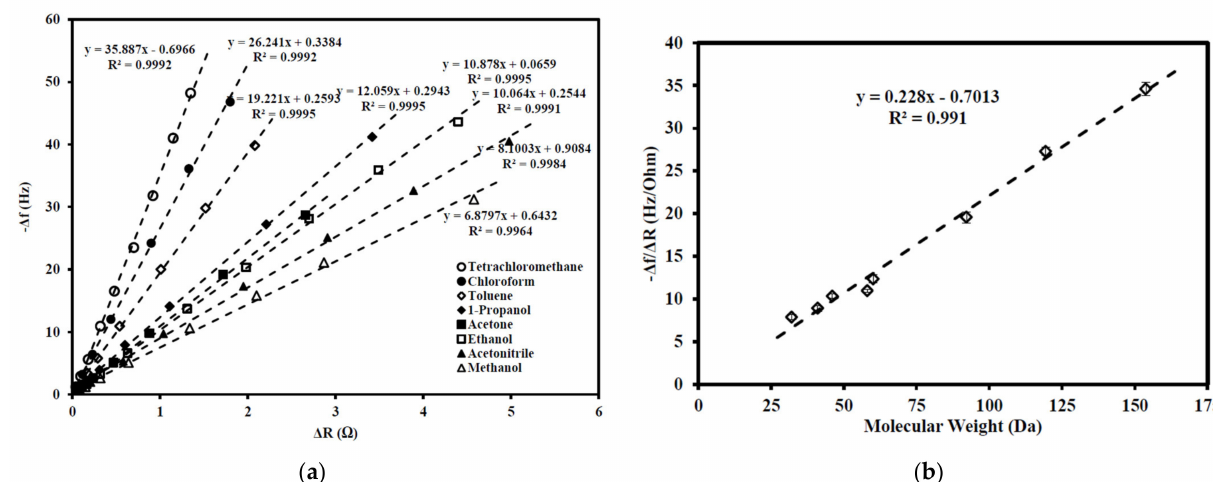
Figure 9. ( a ) Plots of ∆ f against ∆ R for a QCM sensor coated with a composite material on exposure to different or- ganic vapors. The vapor concentration ranges: 1.93–77.0 mg/L for tetrachloromethane, 0.720–28.8 mg/L for chloroform, 0.209–8.36 mg/L for toluene, 0.194–11.7 mg/L for 1-propanol, 0.191–11.5 mg/L for acetone, 0.382–22.9 mg/L for ethanol, 0.190–4.75 mg/L for acetonitrile, and 0.574–23.0 mg/L for methanol. ( b ) Variation of ∆ f/ ∆ R as a function molecular weight of organic vapors. Error bars represent the standard deviations (n = 6–8). Figure is reproduced from [99]. Figure 10 shows ∆ f at different harmonics on exposure to petroleum ether